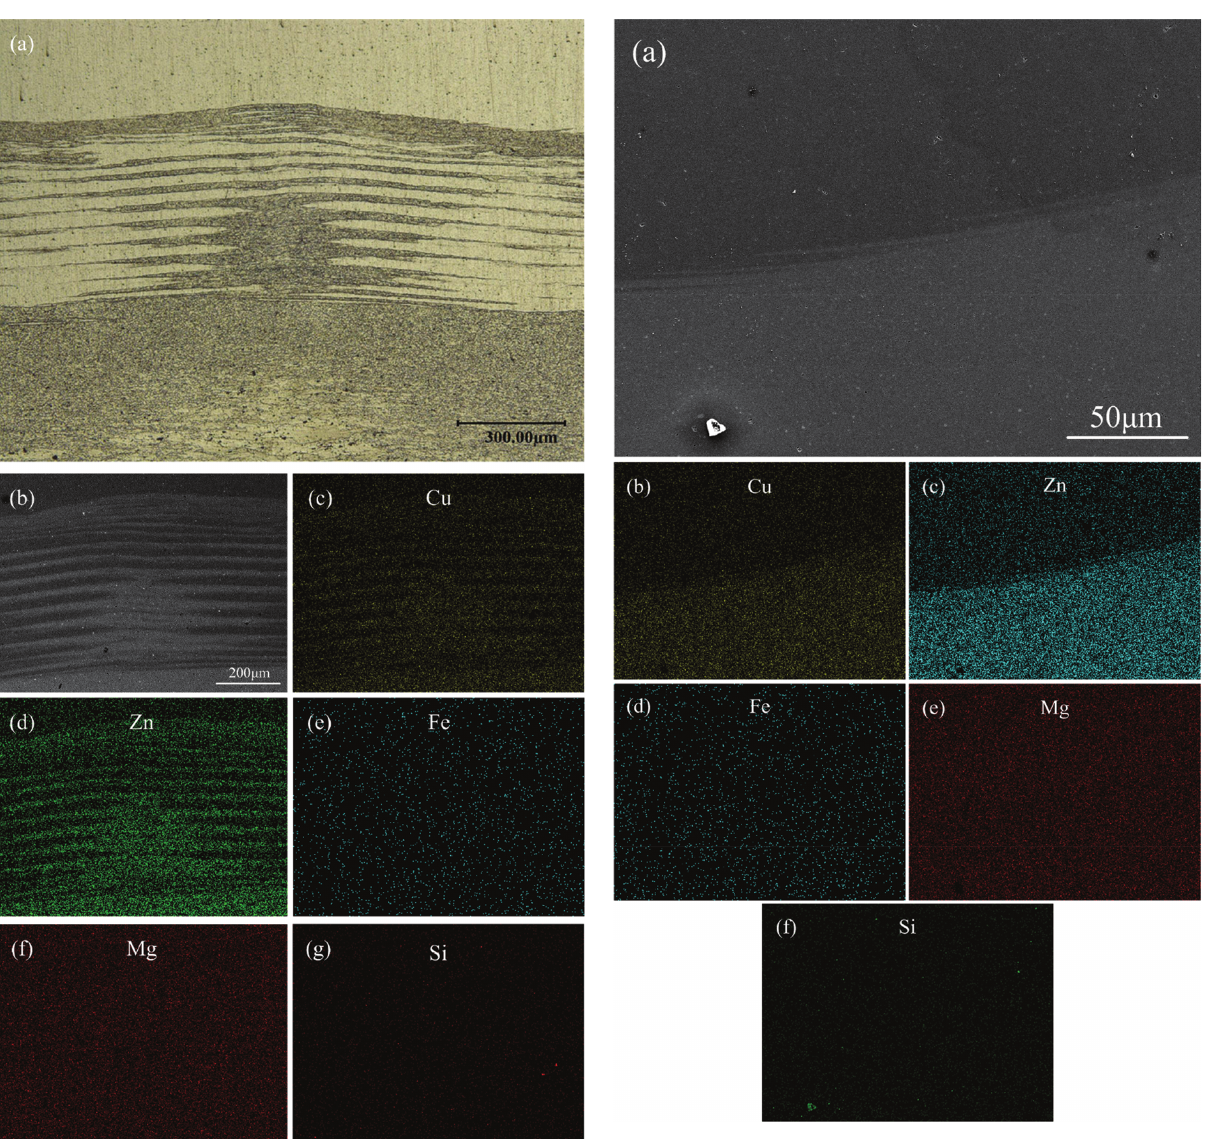
Figure 6: Microstructure of the joint using 3.8 mm: (a) SEM image of joint center, (b) Cu, (c) Zn, (d) Fe, (e) Mg and